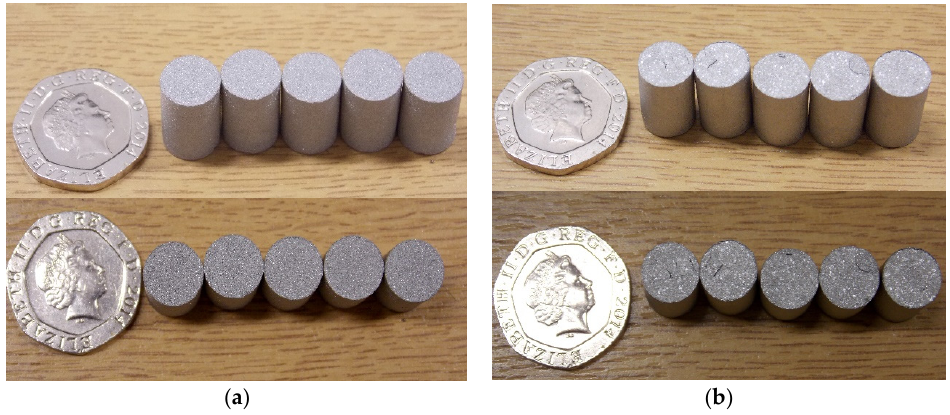
Figure 7. ( a ) Side and top views of the sintered samples made by coarse powder; ( b ) side and top views of the sintered samples made by commercial feedstock PolyMIM Grade 2.